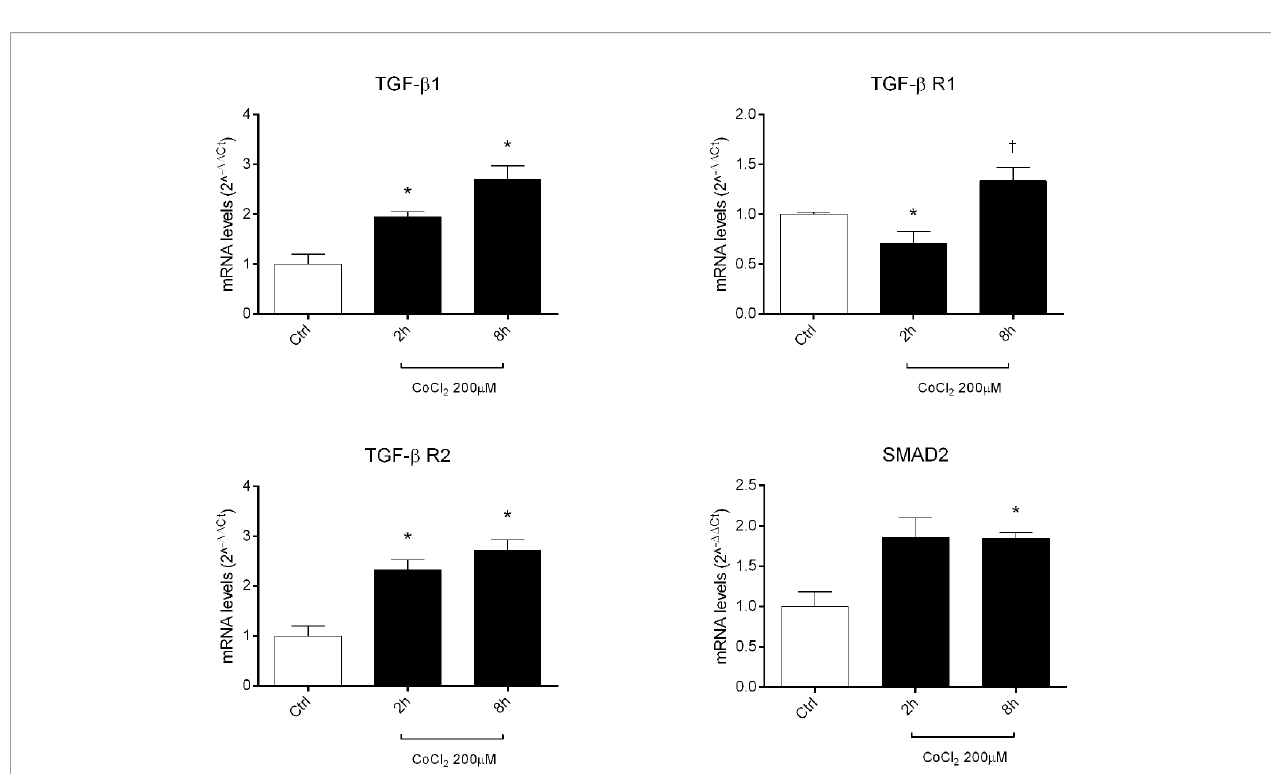
FIGURE 5 | Expression of genes of TGF b signaling pathway in human retinal endothelial cells (HRECs) treated with CoCl 2 , for 2 and 8 h. The mRNA levels were evaluated by qRT-PCR. Each bar represents the mean value ± SD. *p < 0.05 CoCl 2 vs. control (ctrl); † p < 0.05 8h vs. 2h CoCl 2 treatment.